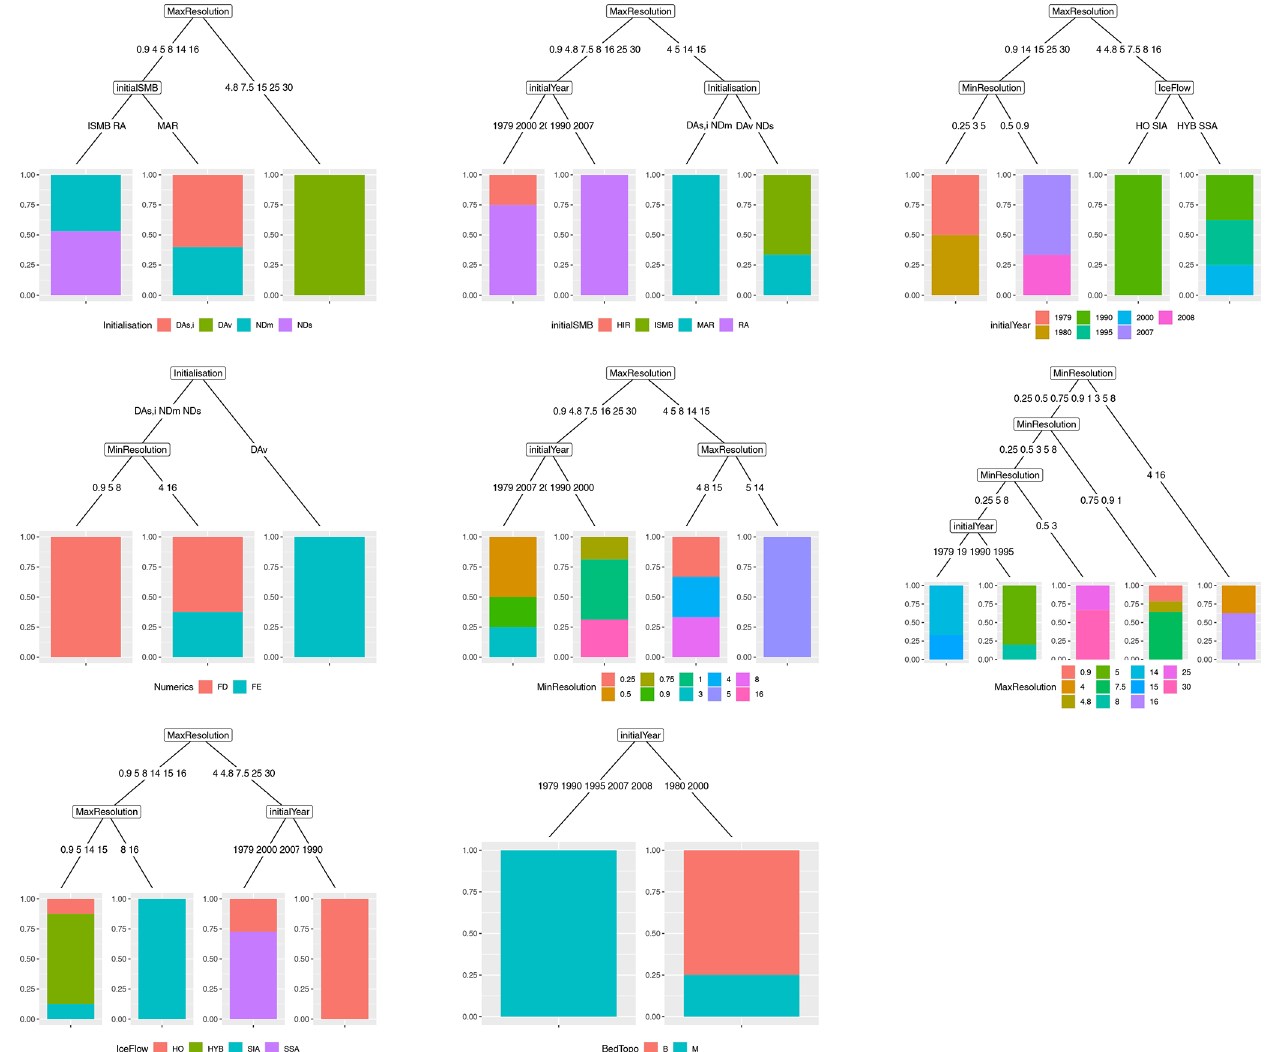
Figure 4. Tree models representing the dependence between the different modelling assumptions (indicated at the bottom of each tree). The bottom nodes (leaf nodes) provide the proportion of experiments given the modelling choices defined along the branches of the tree model. Each colour corresponds to a different category of the considered modelling assumption. For instance, the left tree in the middle row provides the relation between the choice in the numerical method with the type of initialisation and the minimum grid size. The blue (red) colour is related to the finite element FE (finite difference FD)